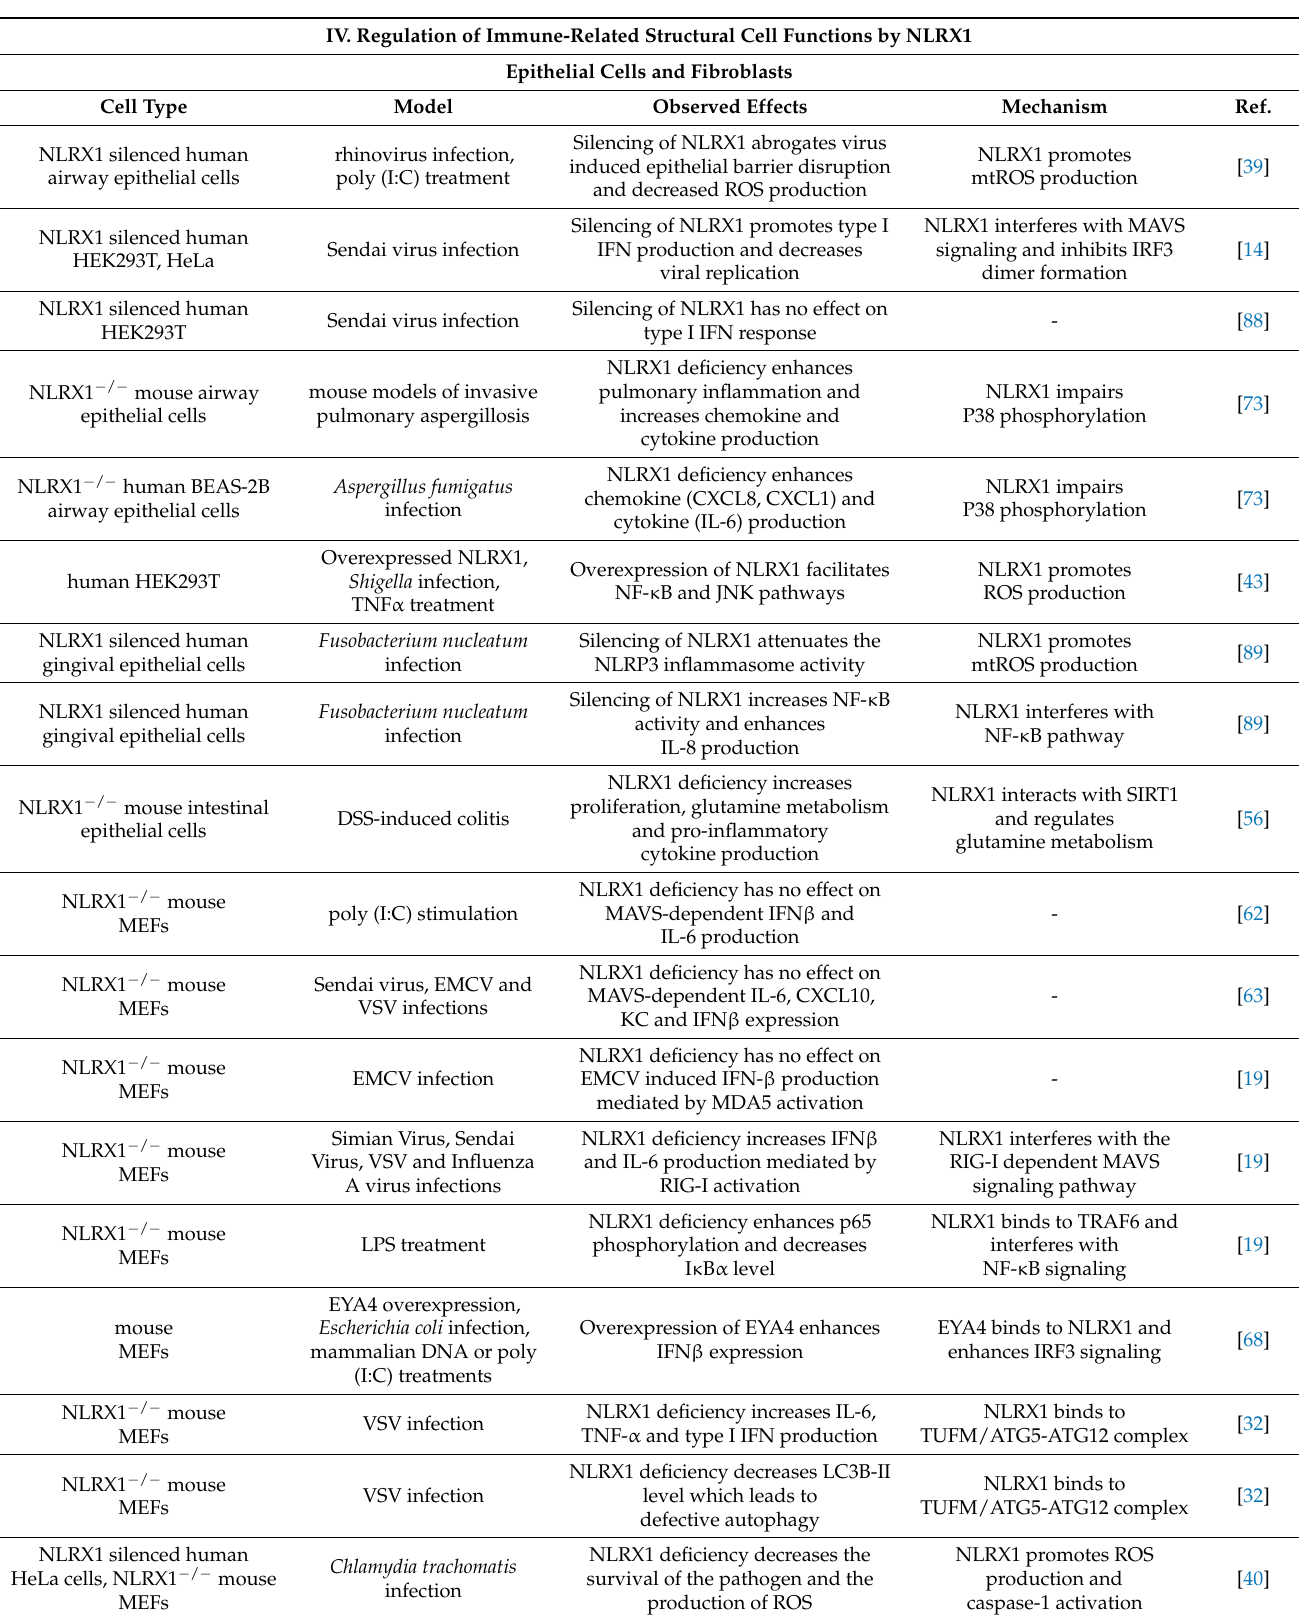
Table 4. Regulation of immune-related structural cell functions by